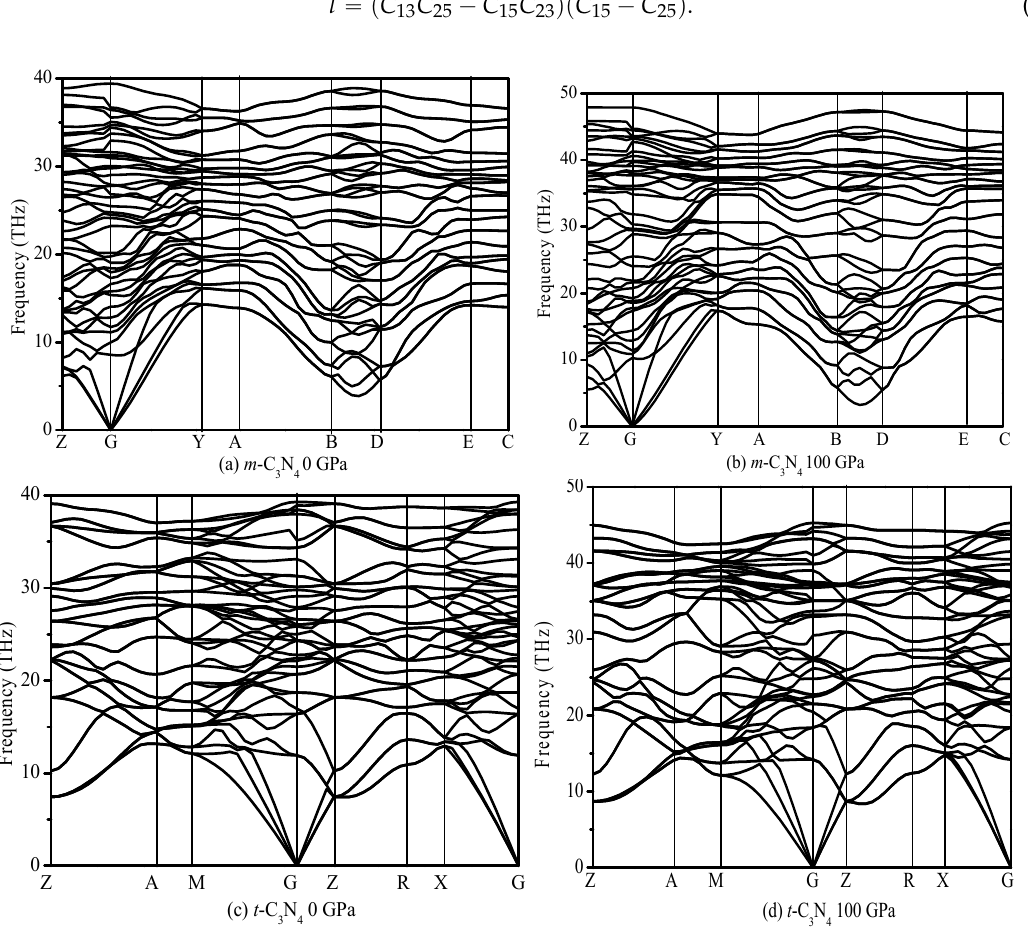
Figure 4. Phonon spectra for: m -C 3 N 4 ( a , b ); and t -C 3 N 4 ( c , d ).